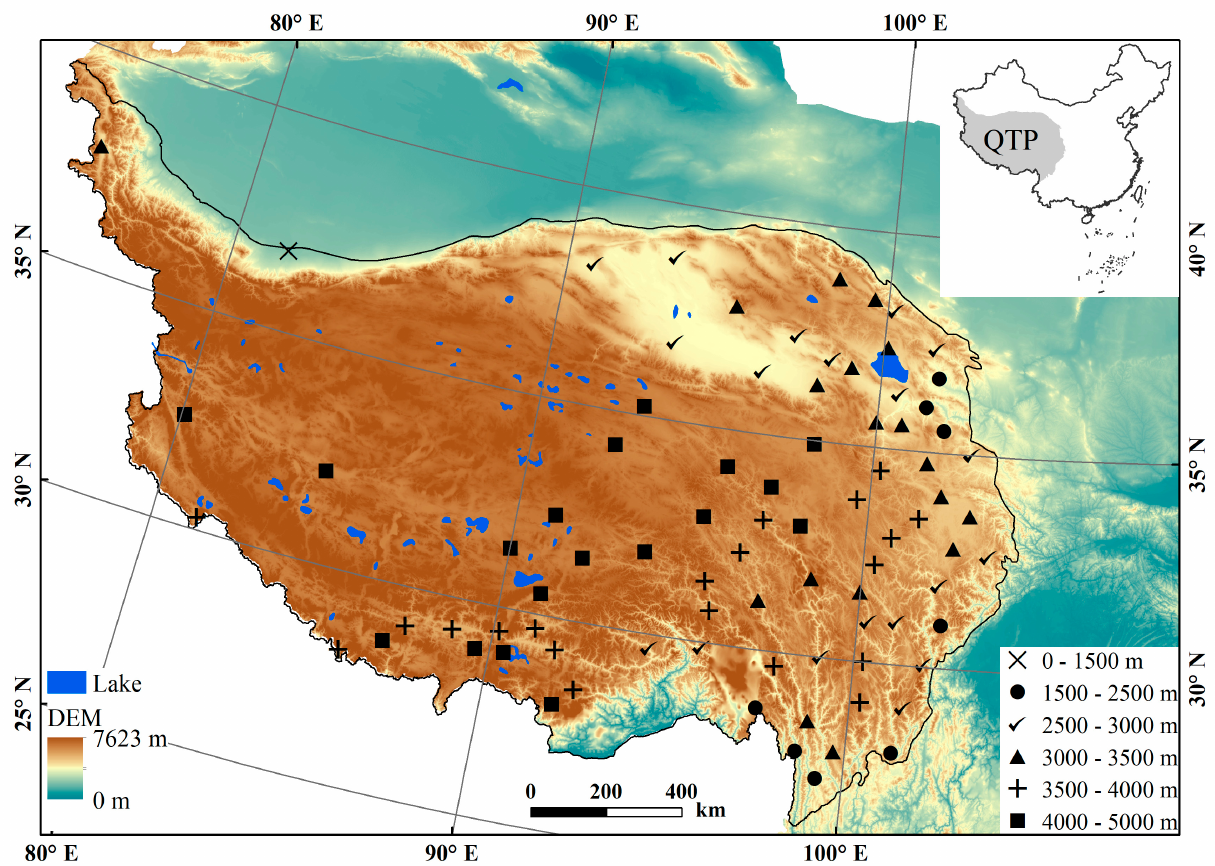
Figure 1. Location of the Qinghai–Tibetan Plateau (QTP) and the spatial distribution of 84 meteorological stations. The boundary of the QTP is provided by the National Tibetan Plateau Data Center (https://data.tpdc.ac.cn/zh-hans/data/0231c972-8460-4691-a187-70e4cc356f60 (accessed on 1 October 2022)). The background coloration reflects the altitude. DEM: digital elevation model.